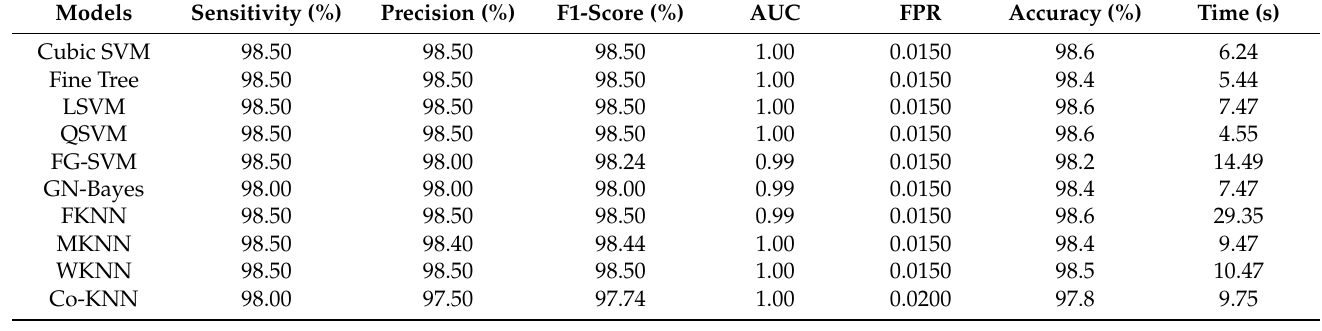
Table 17. Classification results using MEWOA Fine-tuned Nasnet deep features for INbreast.